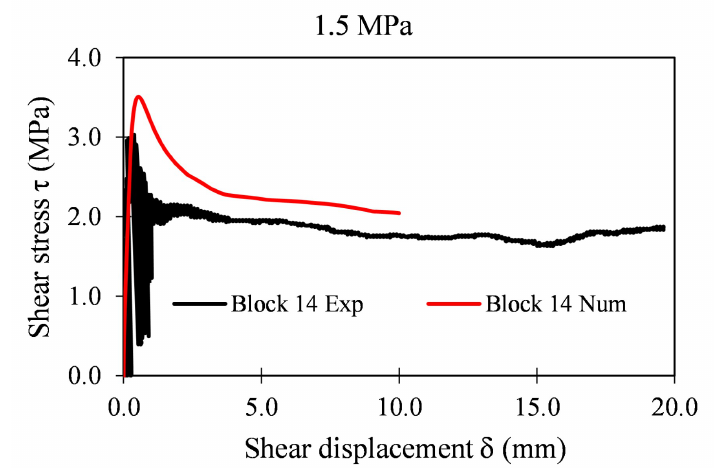
Figure 35. Shear stress evolution with displacement Exp–Num (Block 14).